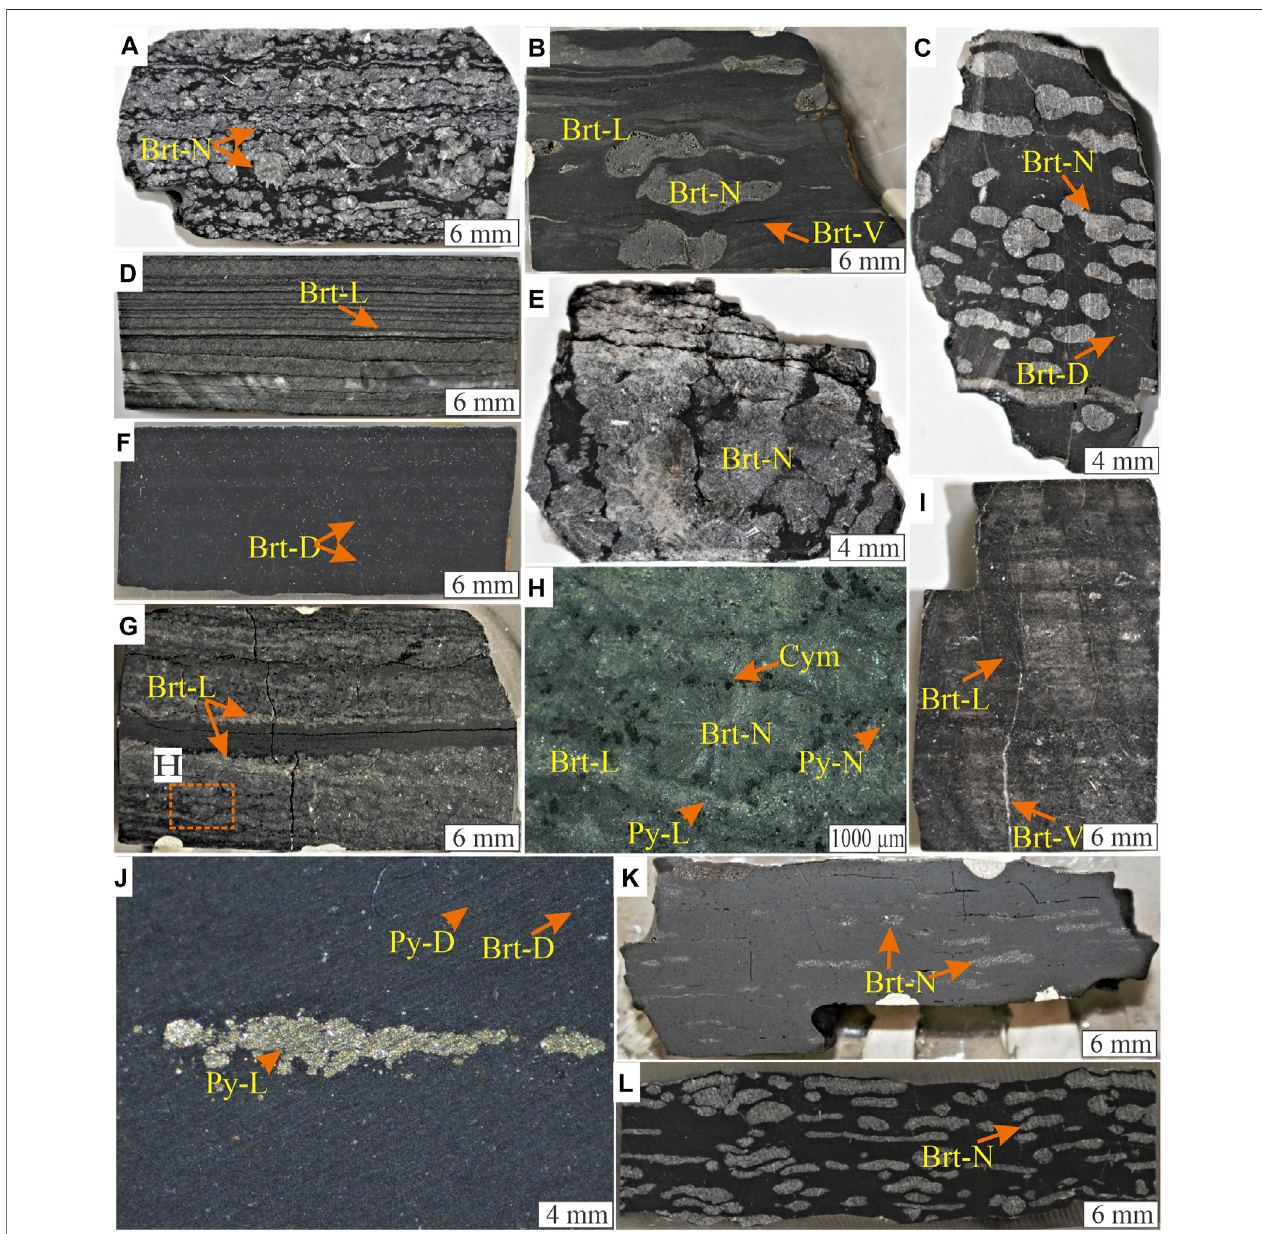
FIGURE 4 | Representative hand specimen and binocular photographs of mudrocks showing different forms of barite mineralization. (A) Black carbonaceous mudstonewithnodularbaritegrains(Brt-N). (B) Darkgreyshalewiththinbaritelaminations(Brt-L)andnodular(Brt-N)irregularbaritegrains.Darkgreybariteveins(Brt-V) are observed to have formed parallel to the bedding. (C) Dark grey siliceous mudstone showing nodular barite. (D) Grey siliceous shale with thinly laminated barite. (E) Large barite nodules within dark grey siltstone. (F) Black carbonaceous mudstone. Disseminated barite (Brt-D) is commonly associated with anhedral quartz grains. (G) Laminatedandrosettenodularbaritewithstratiformpyriteandbariteareintergrownwithcymrite(cym)in (H) . (I) Rarelimedarkgreymudstonewithdiscordant barite vein. (J) Binocular microscope photograph of black mudstone with disseminated pyrite (Py-D) and aggregates of stratiform pyrite (Py-L). (K) Dark grey siliceous shale showing ellipsoidal barite nodules parallel to the bedding. (L) Highly irregular barite nodules in black carbonaceous shale.